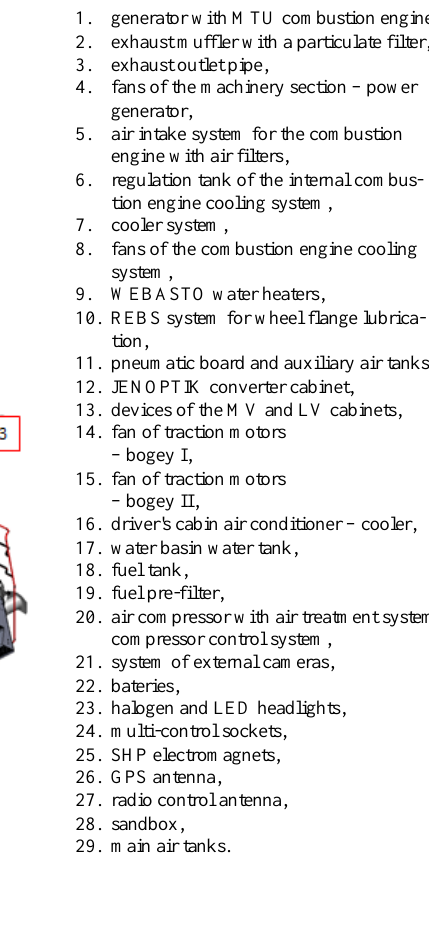
Fig. 12. Arrangement of the main compartments on the 19D locomotive (left and top view)